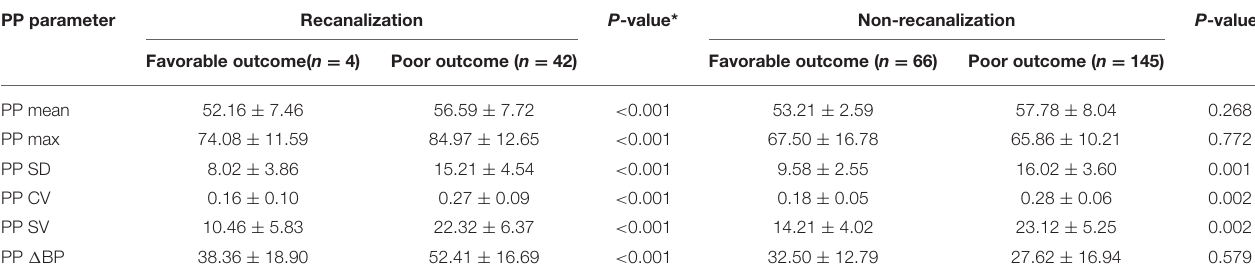
TABLE 2 | Blood pressure variability parameters between favorable and poor outcomes. PP parameter